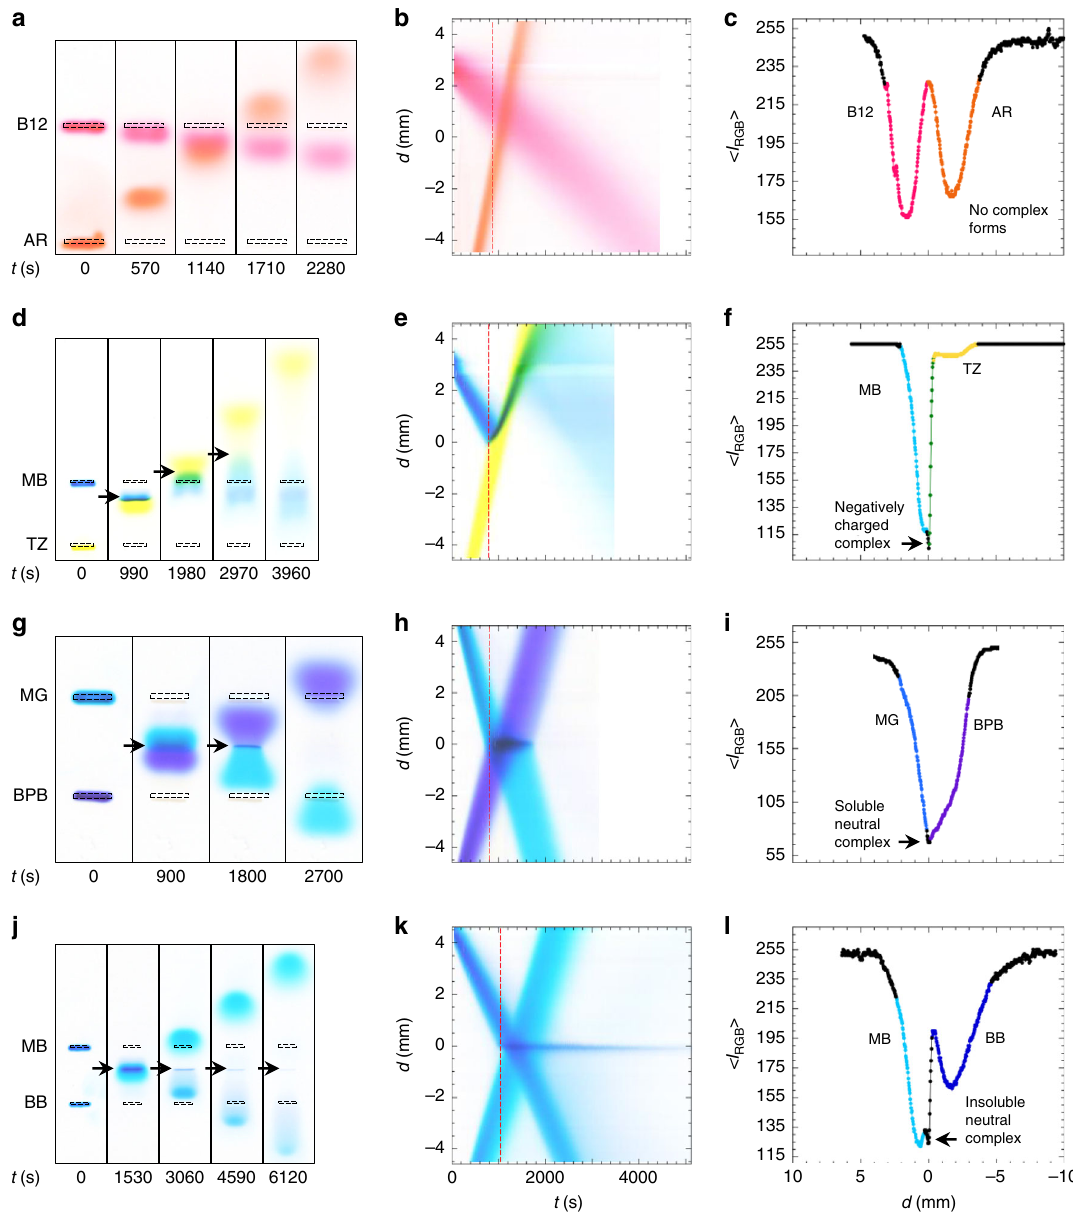
Fig. 4 Optical visualization of complexing and decomplexing reactions between counter-propagating bands of organic dyes using BCGE. Conditions: 3.0% (w/w) agarose gel concentration, 5.0 mM sodium borate buffer at pH 9.0; electric fi eld strength E = 3.1 V cm − 1 . Each well is loaded with 4 µ L of a dye solution at 4.5 mM and measures 4 -mm wide. Shown for dyes B12 and AR: a background-subtracted overhead images at different times t after turning on E ; b space – time plot of the center strip of pixels in the lane from part a , where the spatial position d along the lane is set to zero at the collision point; and c average RGB image intensity pro fi le (corresponding to red dashed line in part b ); lines guide the eye. The results for dyes MB and TZ are similarly shown in d , e , f ; dyes MG and BPB in g , h , i ; and dyes MB and BB in j , k , l . Arrows indicate complex formation. The x -direction points downward in spatial plots. Colors in parts c , f , i , and l are approximate guides only. Figure 2 de fi nes dye abbreviations. Horizontal axes for b , e , h are the same as in k ; horizontal axes for c , f , i are the same as in l . Source data are provided as a Source Data fi